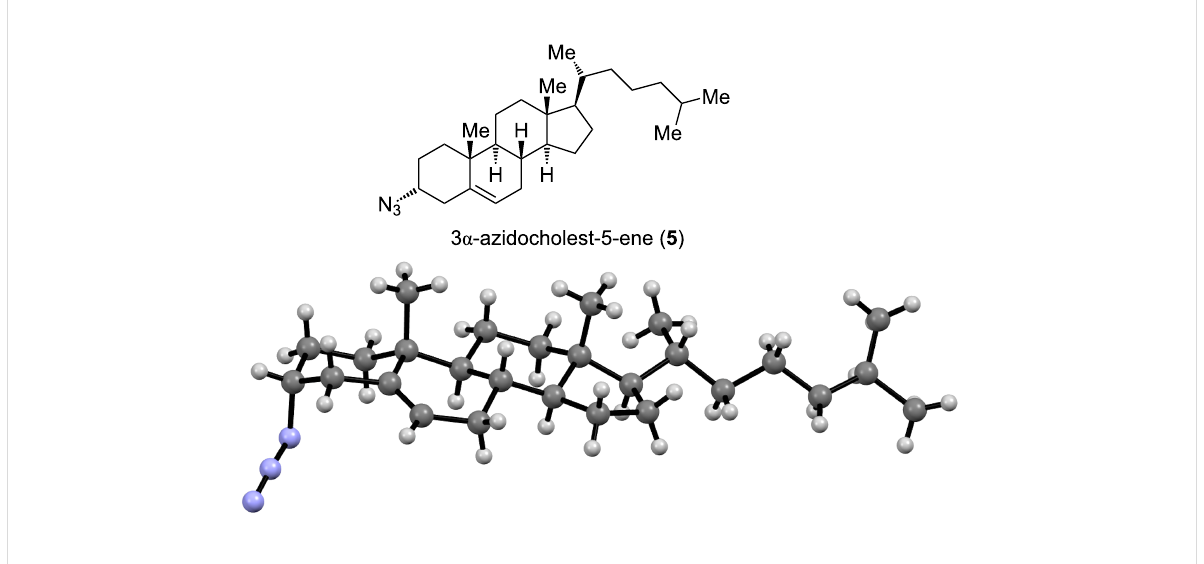
Figure 5: Top: 3 α -azidocholest-5-ene ( 5 ) obtained by treatment of 4 with NaN 3 in DMF; bottom: X-ray crystal structure [18] of 5 (CSD [24,25] refcode HOFFUE).